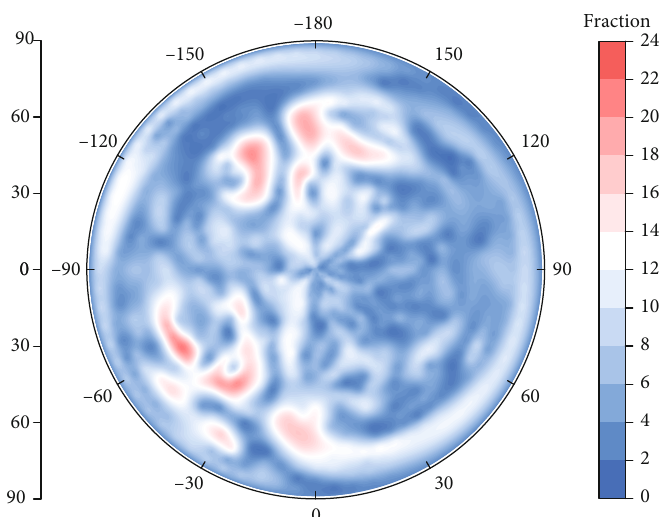
Figure 8: Graphical recognition of splitting